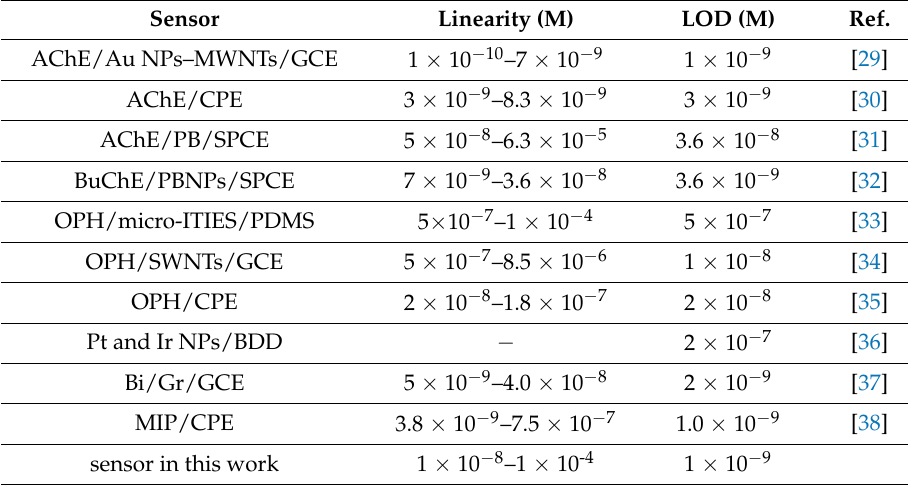
Table 2. Performance comparison of the imprinted PATP/AuNPs/SPCE sensor in this work and other reported sensors for determining